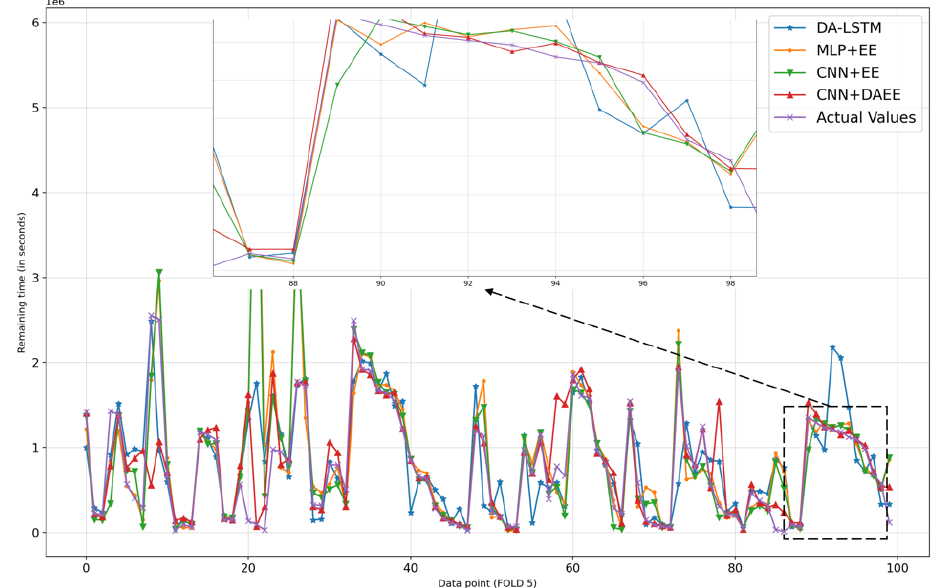
Figure 11. Comparison of results of four models for 100 sample test sets in fifth iteration of CV.